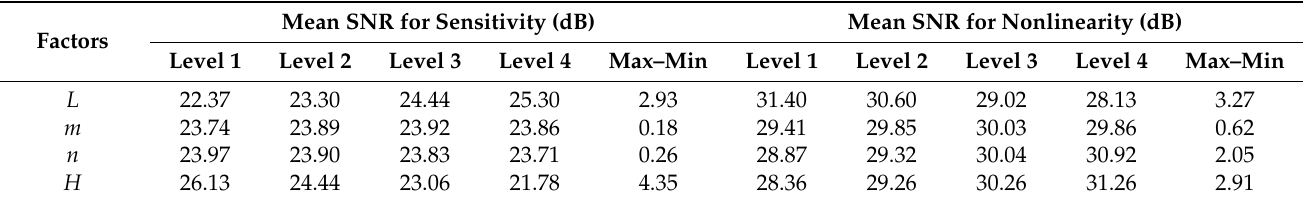
Table 3. Response table of average SNR for sensitivity and nonlinearity for the L 16 orthogonal table.